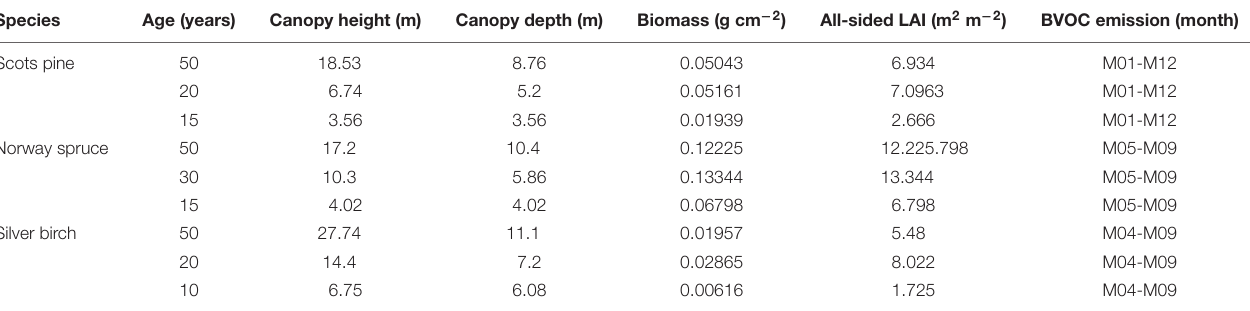
TABLE 2 | The characteristics of stands used in modeling the emissions of organic vapors (BVOC) by MEGAN2.04 and the formation of secondary organic aerosols (SOA) by SOSAA. Species Age (years) Canopy height (m) Canopy depth (m)